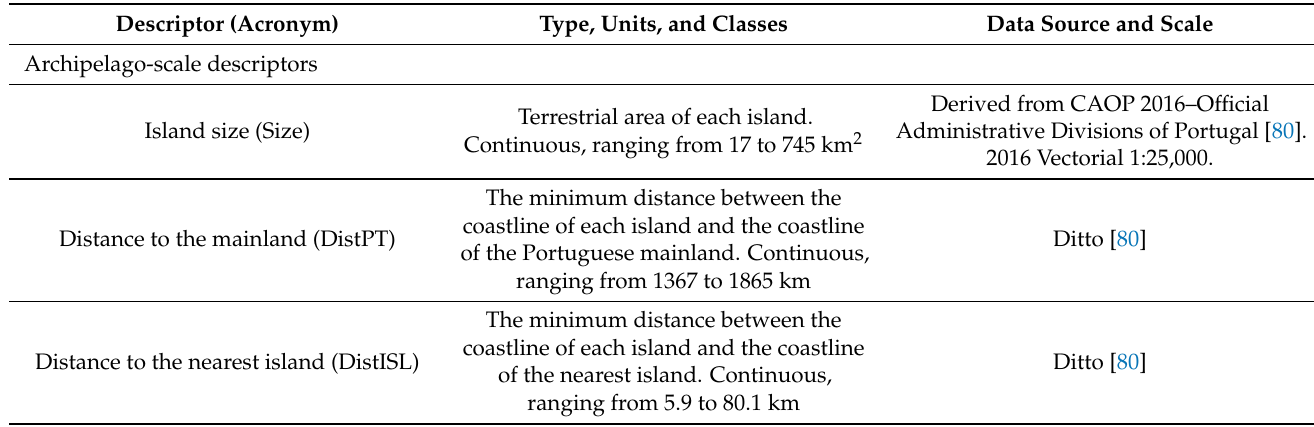
Table A1. Description of the predictor variables used in species distribution models and the data sources from which they were